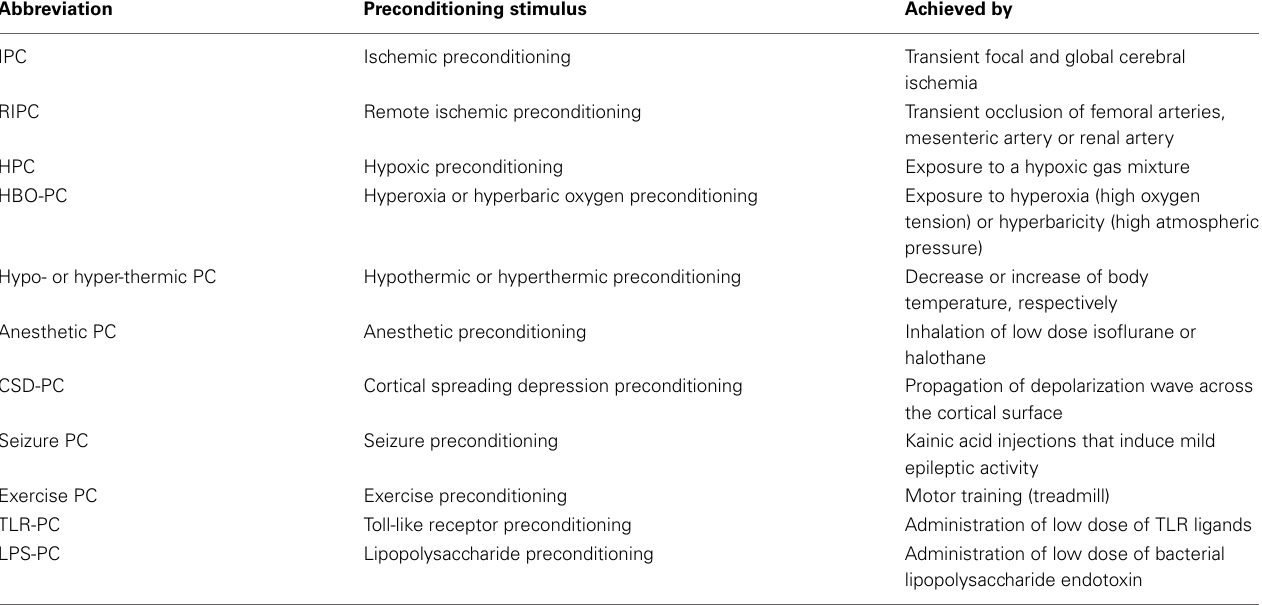
Table 1 | List of preconditioning stimuli inducing ischemic